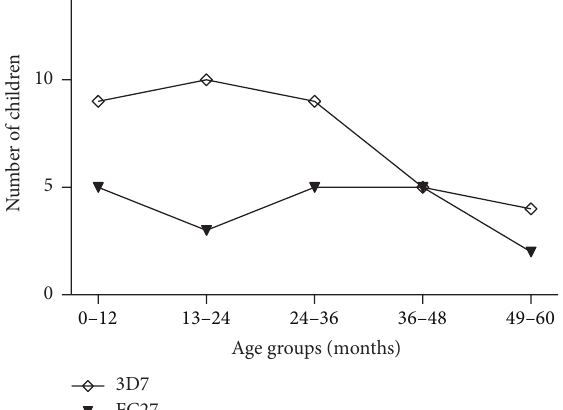
Figure 4: Relationship between mean parasite density and parasite genotypes in each age group ( 𝑁 = 83 ). Significant difference betweenmeanparasitedensities(ANOVA 𝐹 (2,4)=4.2, 𝑝 = 0.0389 ).